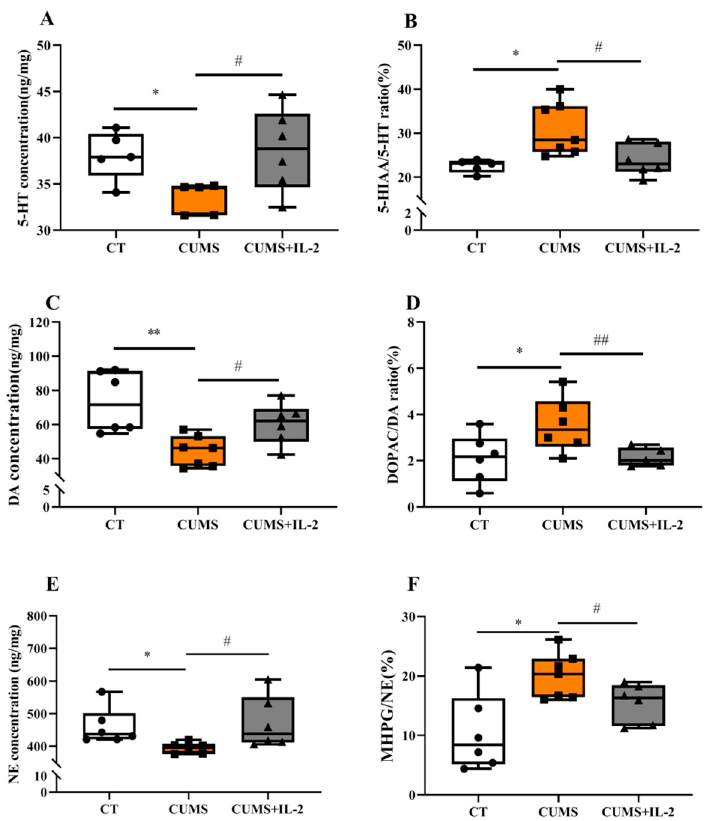
Figure 3. IL-2 normalized the concentration of monoamine neurotransmitters and their metabolites in the hippocampus and amygdala of CUMS mice. 5-HT ( A ), DA ( C ) and their turnovers ( B , D ) in the hippocampus; NE ( E ) and its turnover ( F ) in the amygdala (n = 6–8). CT, control; CUMS, CUMS group; CUMS+IL-2, CUMS exposure with IL-2 treatment. ** p < 0.01, * p < 0.05 vs. CT; # p < 0.05, ## p < 0.01 vs. CUMS.